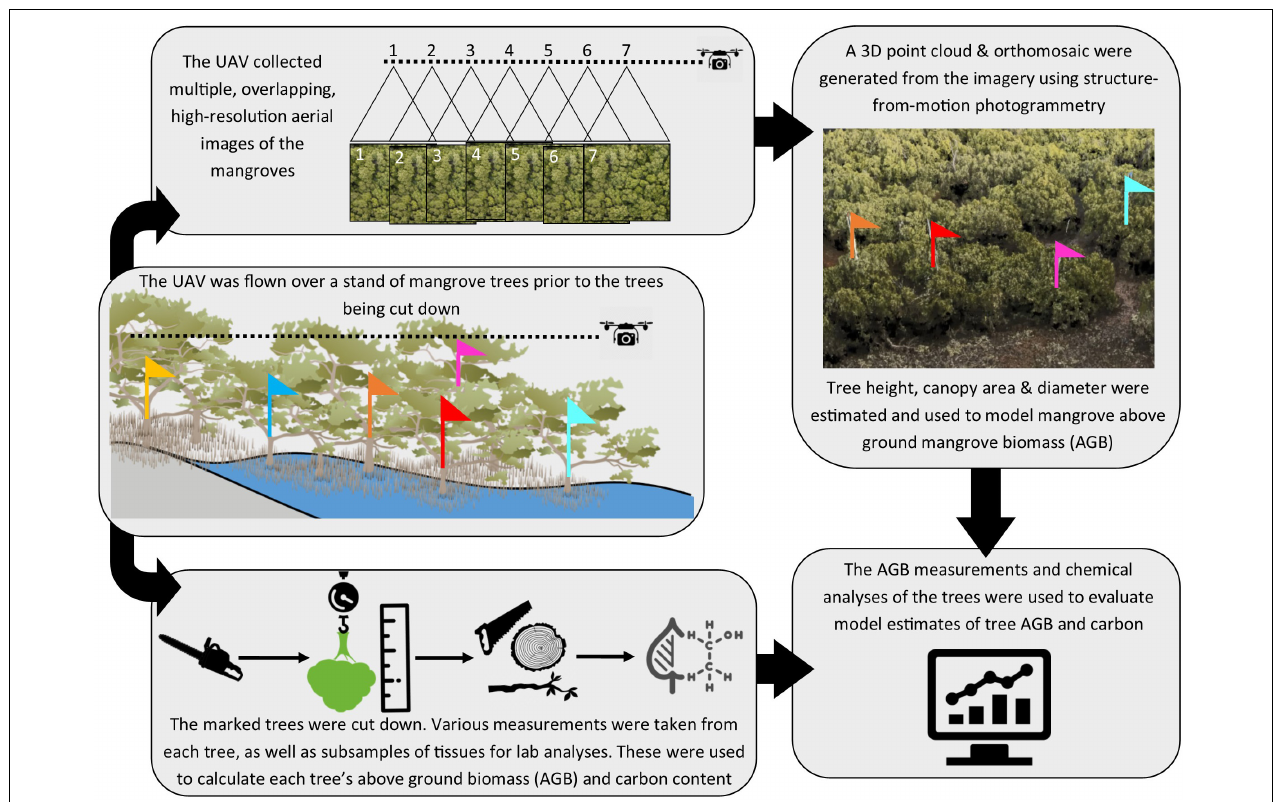
FIGURE 2 | Schematic of workflow used in the study, which was initiated with tree marking prior to UAV flight, with subsequent harvesting of trees and analyses of tree samples and